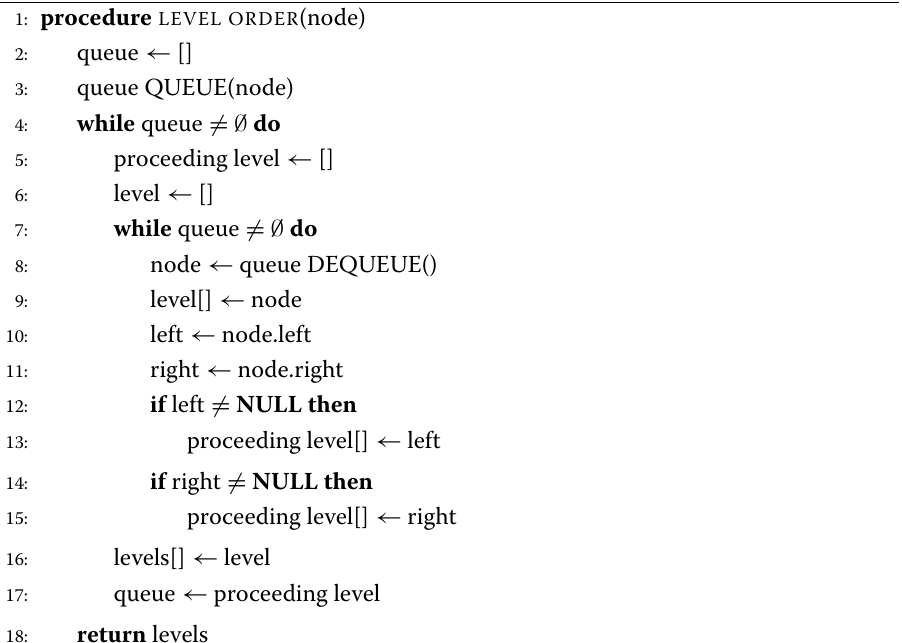
Algorithm 6 Level order of Neural